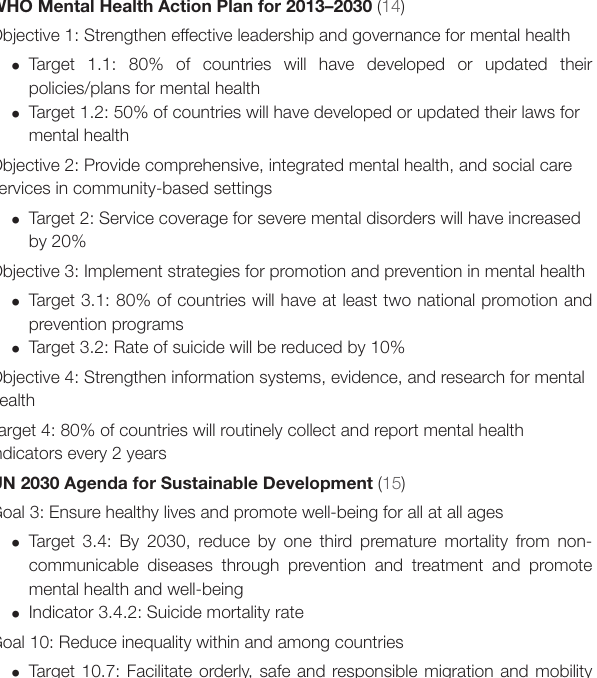
TABLE 2 | Policy frameworks relevant to refugee mental health. WHO Mental Health Action Plan for 2013–2030